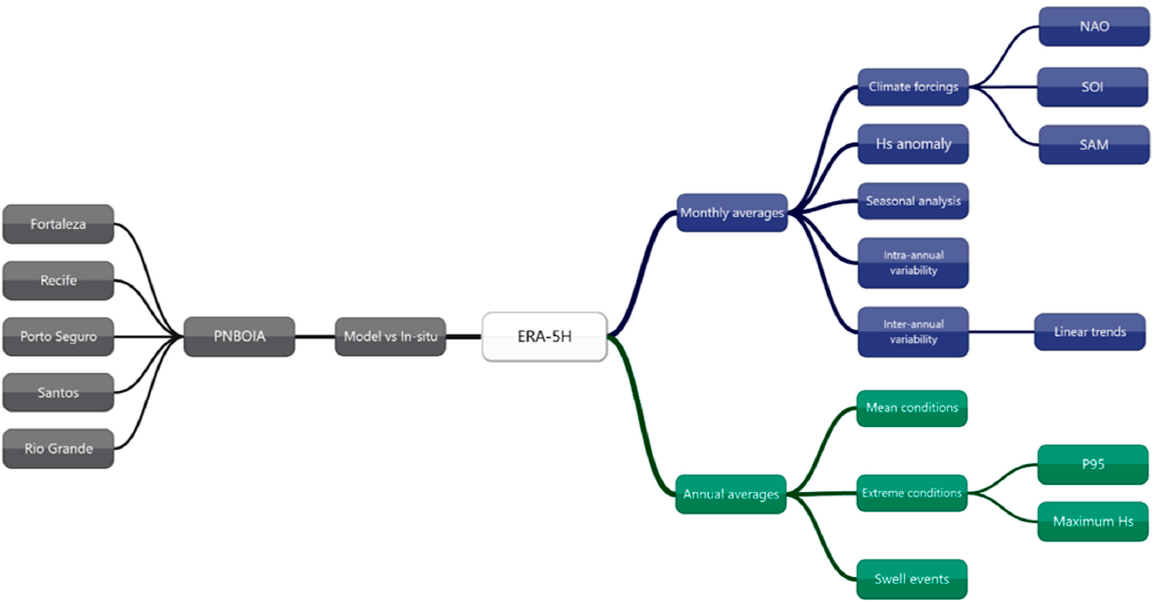
Figure 1. Flow chart of the summary of the methodology